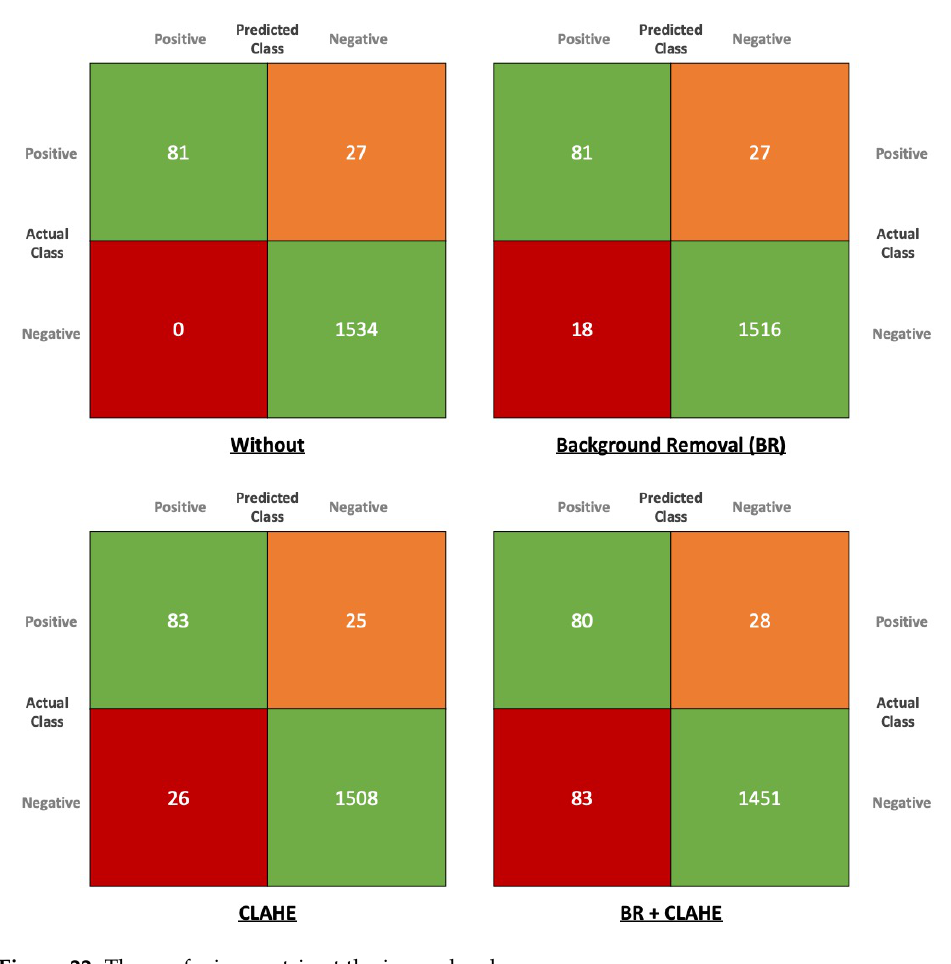
Figure 22. The confusion matrix at the image level.